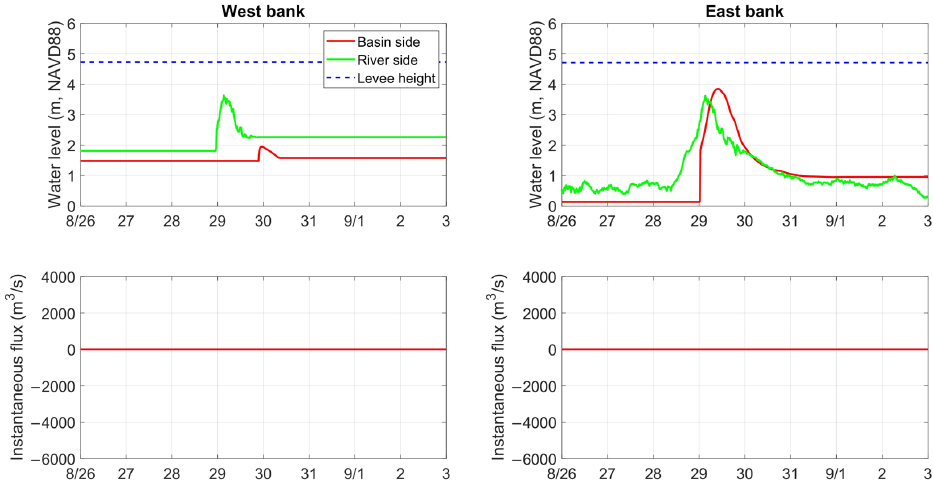
Figure 6. Time series of water level (m, NAVD88, top) and instantaneous flux (m 3 /s, bottom) for the west (left) and east (right) banks at the upper ‐ crossing location in the base case during Isaac (2012). The direction of positive flux is from west to east.